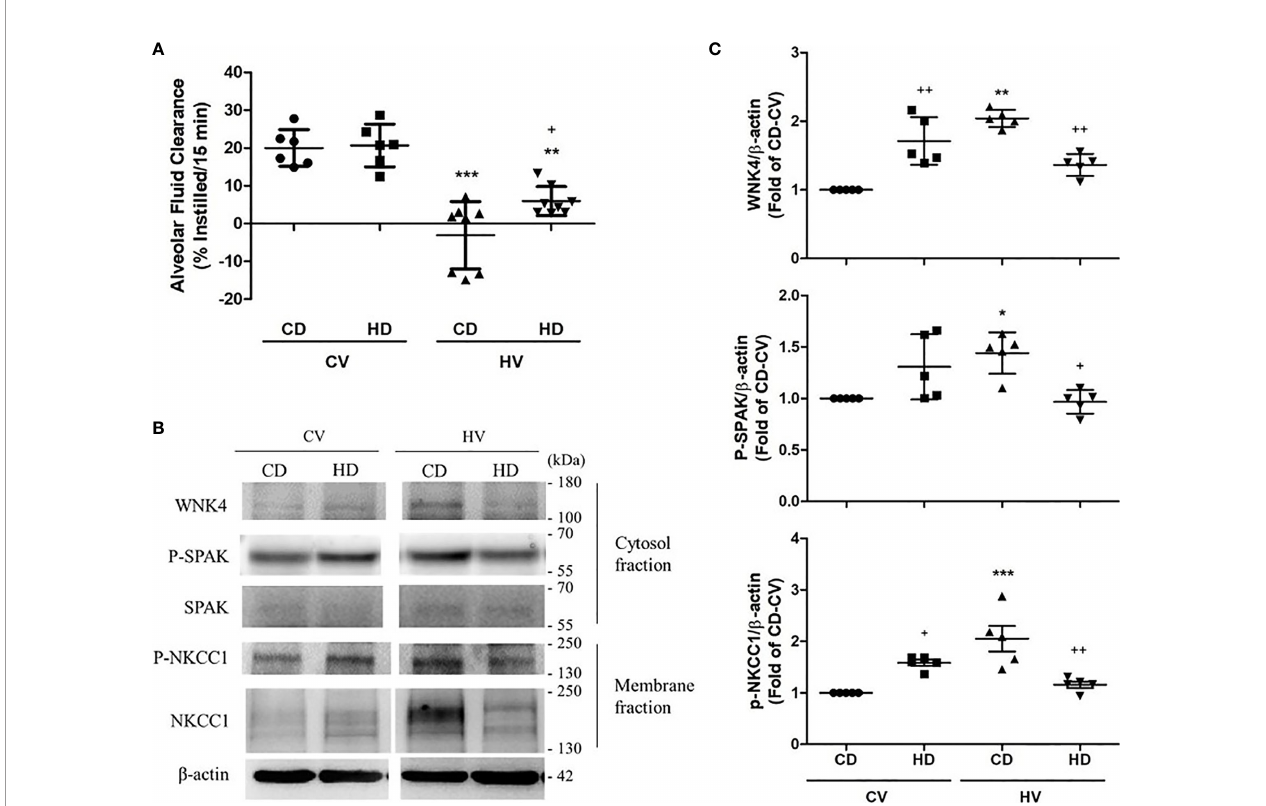
FIGURE 5 | Effects of obesity on alveolar fl uid clearance (AFC) and the WNK4 axis. The data were collected in nonobese mice (CD) and obese mice (HD) after 6 h of spontaneous breathing (CV) or mechanical ventilation (HV). (A) AFC. (B) Western blotting. b -Actin served as the loading control for cytoplasmic proteins. Representative blots are shown. (C) Expression of proteins in the WNK4 axis, including WNK4, p-SPAK, and p-NKCC1. Data are expressed as the mean ± SE (n = 5~10 per group). * P < 0.05, ** P < 0.01, and *** P < 0.001 compared with the corresponding group in the CV condition. + P < 0.05 and ++ P < 0.01 compared with the nonobese mouse group